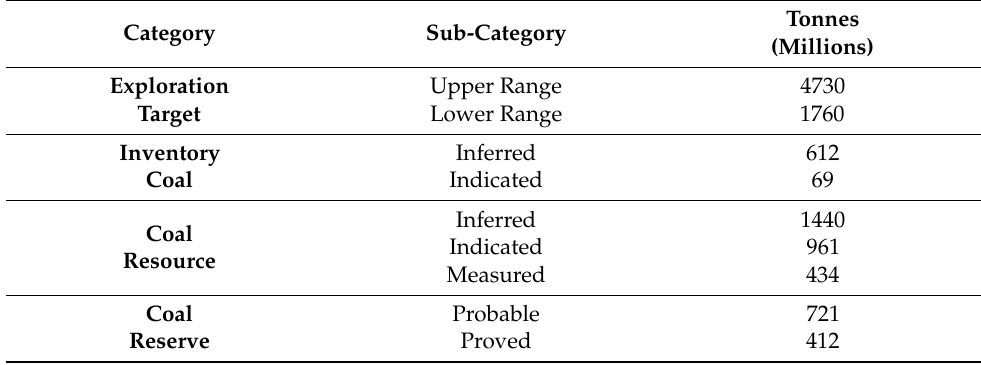
Table 2. Results for hypothetical case study of tonnes of coal for different resource and reserve levels.